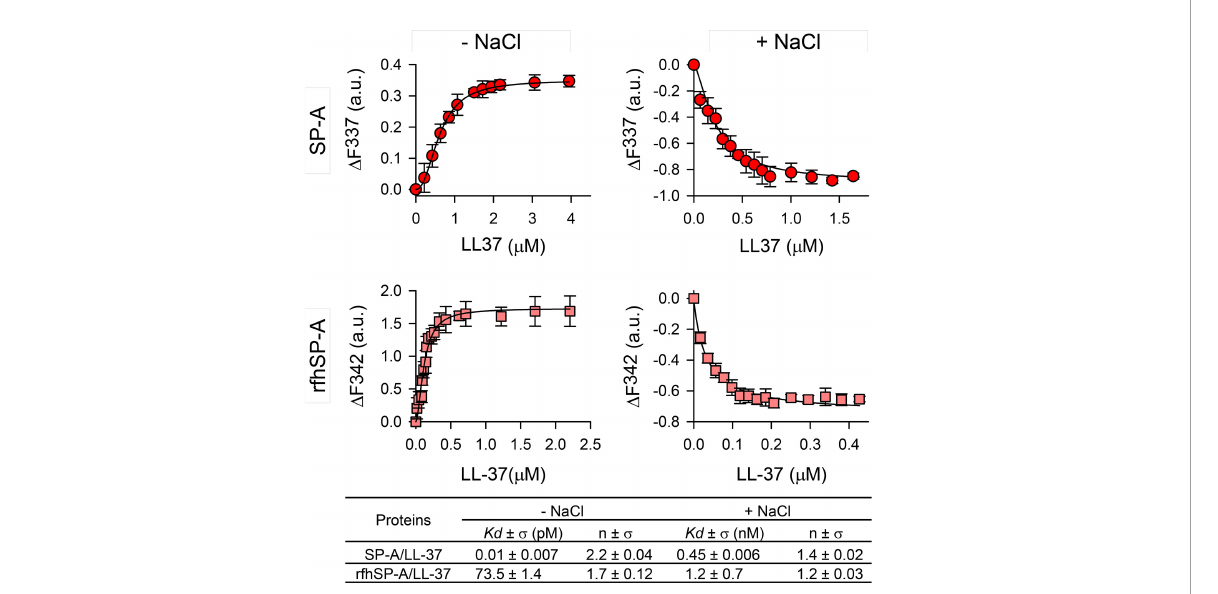
FIGURE 2 SP-A and rfhSP-A interact with LL-37 in a dose-dependent manner. Tryptophan fl uorescence emission spectra of SP-A (75 nM) and rfhSP-A (52 nM) were measured with increasing concentrations of LL-37 at 25°C in 5 mM Tris-HCl buffer (pH 7.4) with (right panels) and without (left panels) 150 mM NaCl. SP-A or rfhSP-A samples (with and without LL-37) and blank samples (LL-37 alone) were excited at 295 nm and the emission spectra recorded from 300 to 450 nm. Results are expressed as D F of the corrected emission intensity at the emission maximum wavelength. Results are means ± SD of three independent experiments. Apparent K D values and Hill coef fi cients for the binding of SP-A and rfhSP-A to LL- 37 in the presence and absence of physiological concentrations of NaCl are